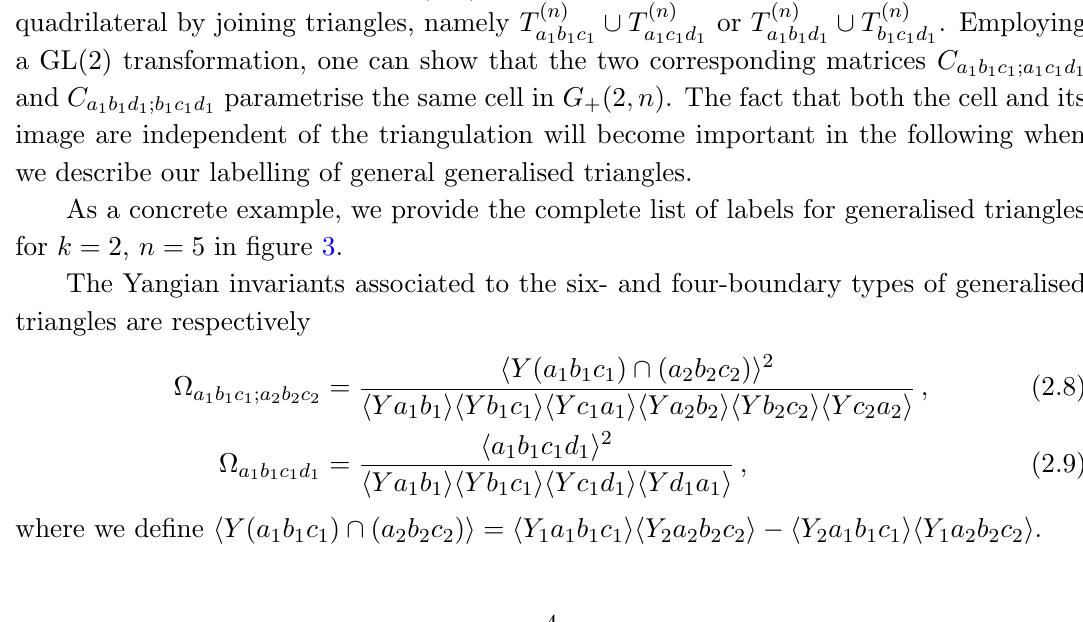
, (b) T ( n ) a 1 ;b 1 ;c 1 ; a 2 ;b 2 ;c 2 a 1 ;b 1 ;c 1 ;d 1